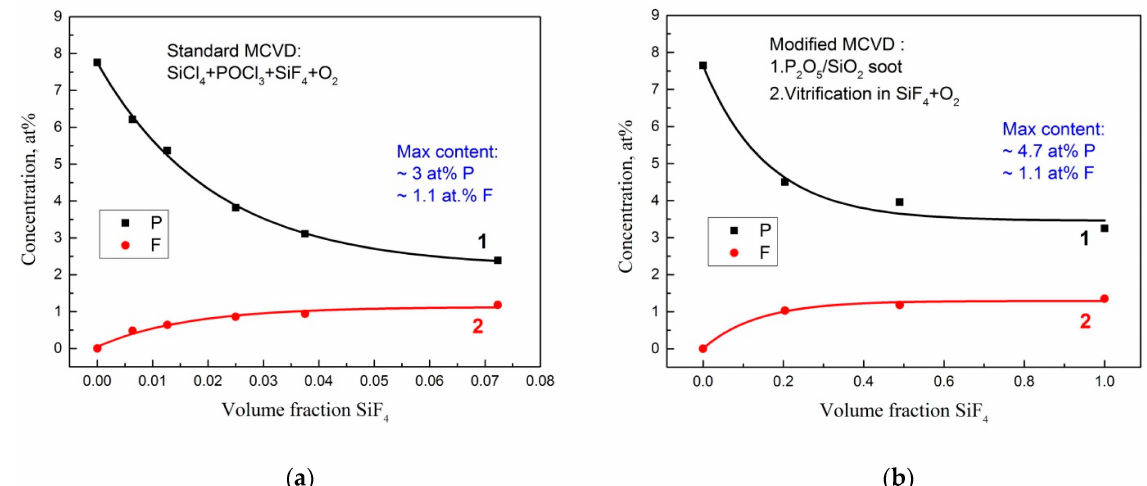
Figure 3. The dependence of P concentration (curve 1) and F concentration (curve 2) in the FPS glass matrix on the volume fraction of SiF 4 gas. The glasses were fabricated: ( a ) by the standard all-gas-phase deposition technique; ( b ) utilizing improved deposition